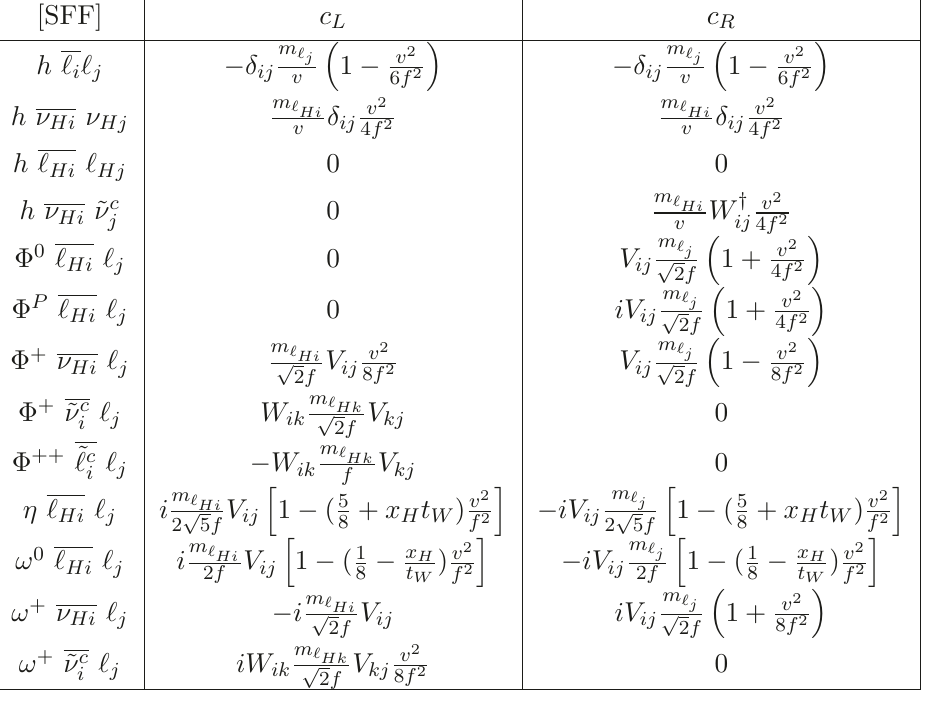
Table 2 . Scalar-Fermion-Fermion couplings at ℓ j does not enter in the calculation of h Φ ++ ˜ ℓ c i other contributions.)